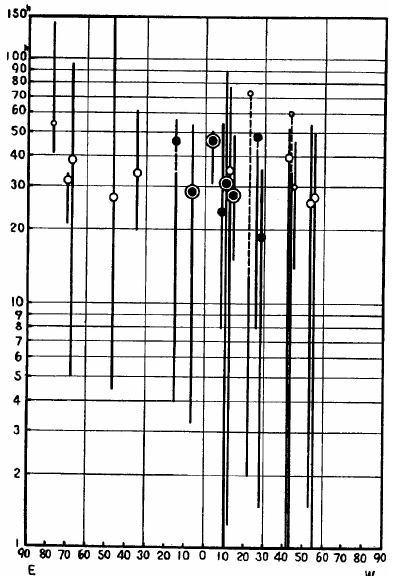
Figure 14. Heliographic distribution of time delays to the polar cap absorptions (where solid lines are drawn throughout their durations) and of geomagnetic storms (where dots indicate the storm intensity) from the Type-IV radio outburst (Obayashi and Hakura,